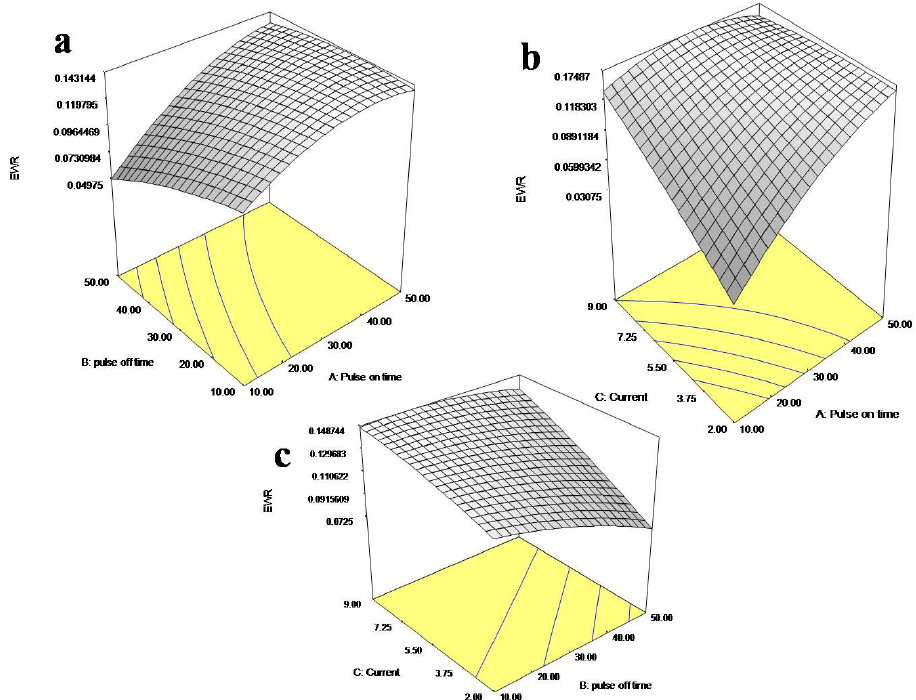
Figure 6: Interaction Plots for EWR (a) Ton Vs Toff; (b) Ton Vs Ip; (c) Toff Vs